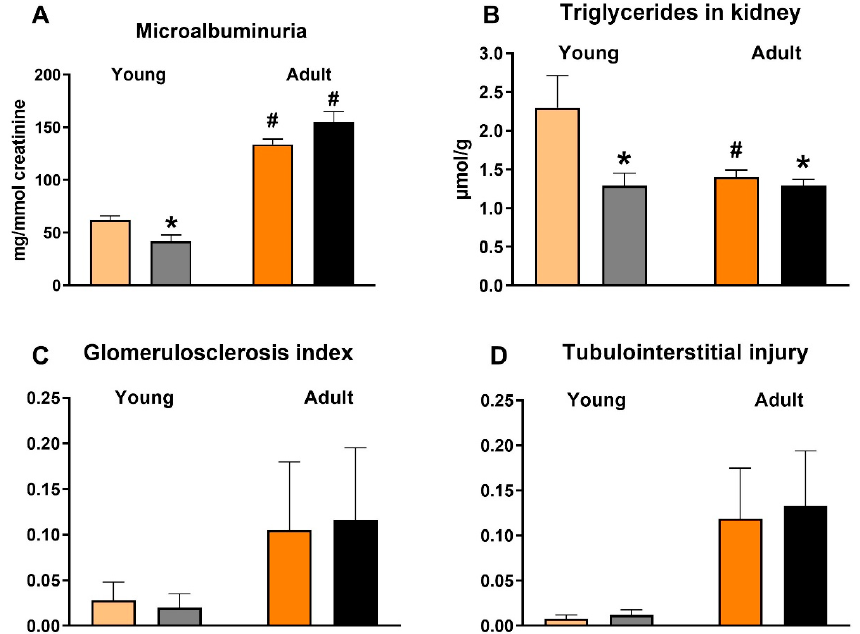
Figure 2. The effect of empagliflozin treatment on microalbuminuria ( A ), triglycerides in kidney ( B ), glomerulosclerosis index ( C ) and tubulointerstitial injury ( D ). * p < 0.05 empagliflozin vs. untreated group, # p < 0.05 vs. respective young group. Data are means ± SEM; n = 7–8 for each